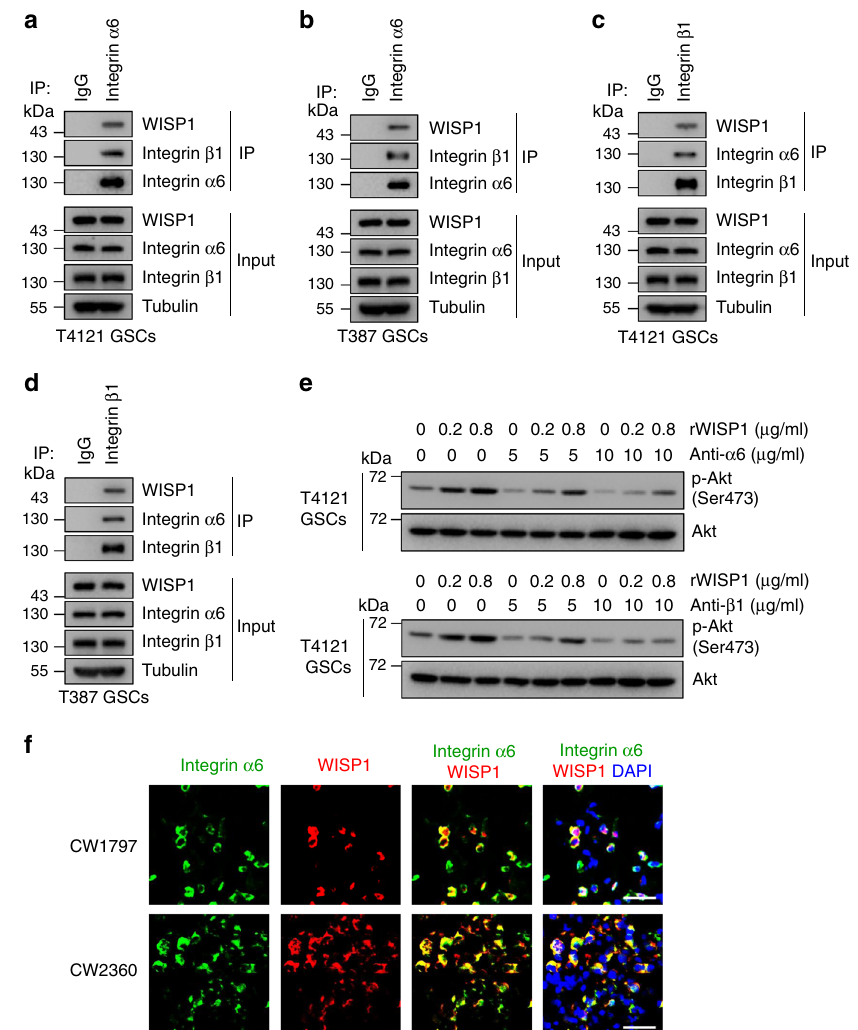
Fig. 6 WISP1 binds to Integrin α 6 β 1 in GSCs. a , b , CoIP assays of protein interaction in T4121 GSCs ( a ) or T387 GSCs ( b ) transduced with WISP1 overexpression lentivirus. Cell lysates were immunoprecipitated (IP) with anti-Integrin α 6 antibody and then immunoblotted with anti-WISP1, anti-Integrin α 6 and anti-Integrin β 1 antibodies. c , d , CoIP assays of protein interaction in T4121 GSCs ( c ) or T387 GSCs ( d ) transduced with WISP1 overexpression lentivirus. Cell lysates were immunoprecipitated (IP) with anti-Integrin β 1 antibody and then immunoblotted with anti-WISP1, anti-Integrin α 6 and anti- Integrin β 1 antibodies. e Immunoblot analysis of Akt phosphorylation (Ser473) in T4121 GSCs treated with 5 or 10 μ g/ml Integrin blocking antibody in combination with 0.2 or 0.8 μ g/ml rWISP1 protein for 12 h. f Immuno fl uorescent staining of Integrin α 6 (green) and WISP1 (red) in human primary GBM samples. Scale bar, 30 μ